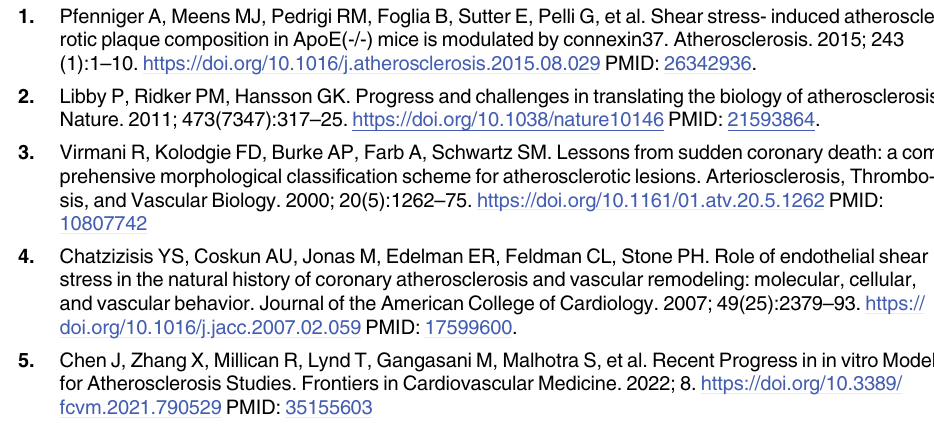
S3 Fig. Original images of immunoblotting of the cells using magnetic beads to separate HCAECs from HCASMCs showed the ability of ECs to express CD31, and VSMCs to express F061—smooth muscle actin. HCAEC: human coronary artery endothelial cell; HCASMC: human coronary artery smooth muscle